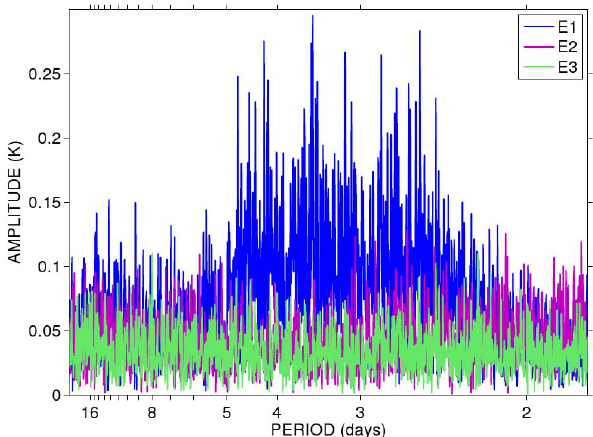
Fig. 7. Spectra showing amplitudes for E1, E2 and E3 wavenumbers resulting from a 2D-FFT of the temperature perturbations as a func- tion of time and longitude. For the 2D-FFT the entire 2005–2010 interval was used. The data are for a height of 97km and within a 10 ◦ latitudinal band centred over the